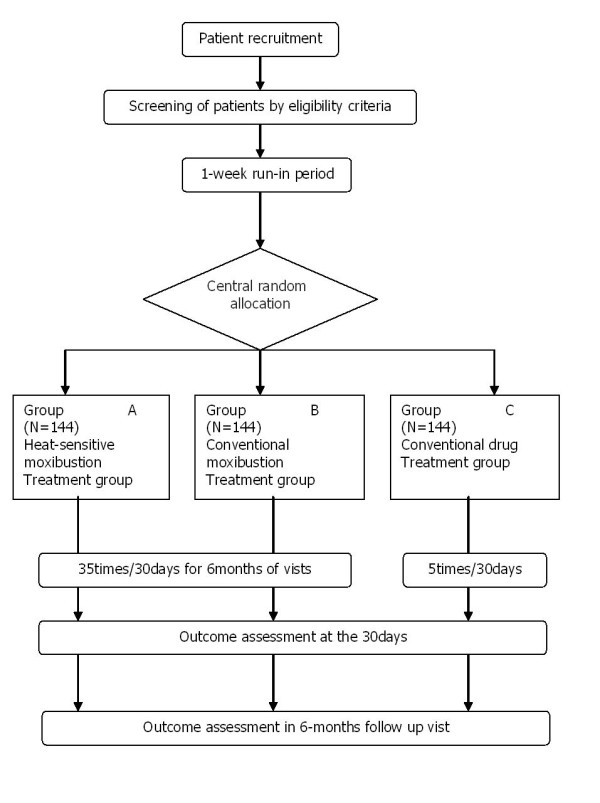
The flow diagram is intended to depict the passage of participants through this RCT.